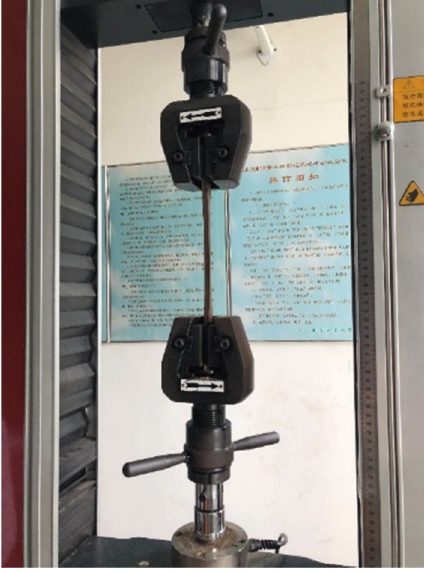
Figure 2: Tension test of the bamboo scrimber. Table 1: Material properties of the bamboo